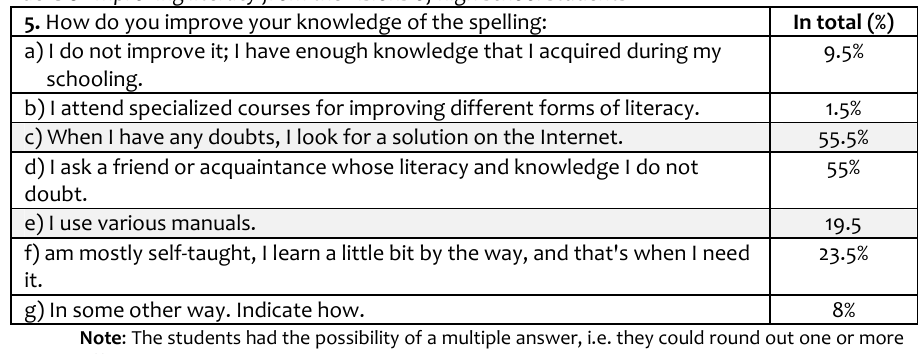
Table 6. Improving literacy from the visions of high school